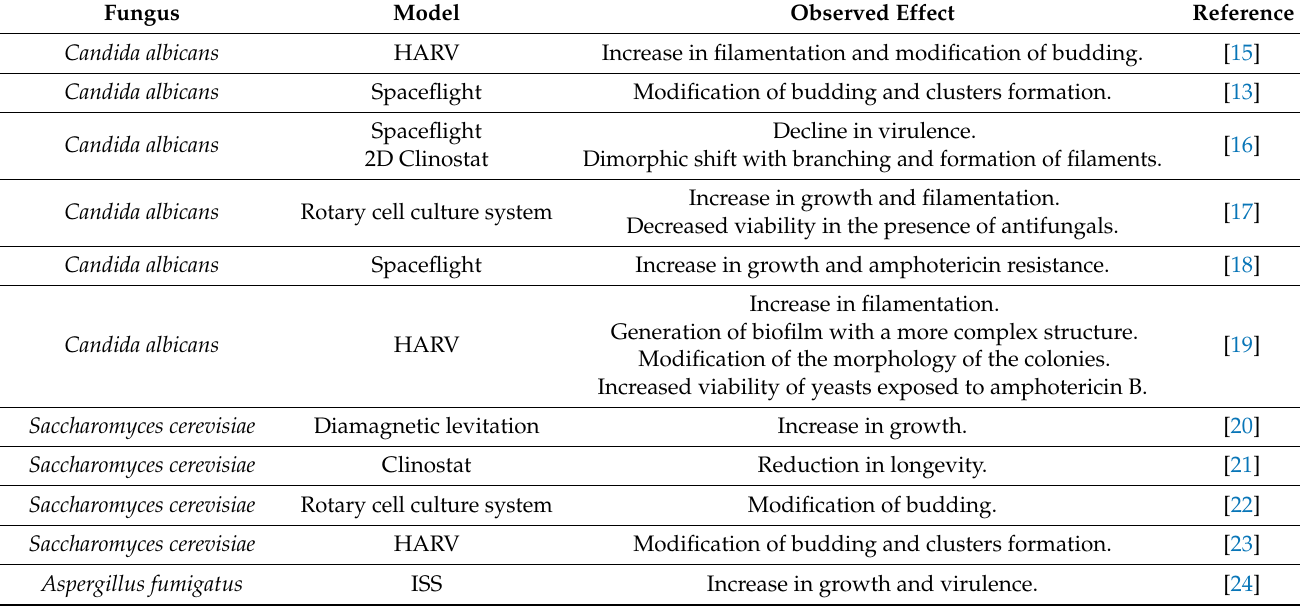
Table 1. Review of the effects of simulated or real microgravity on fungi of medical